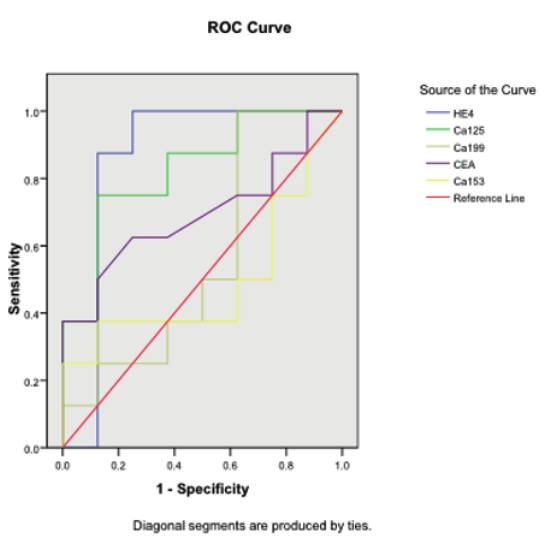
Figure 1 . ROC of examined tumor markers Table 3. Correlation coeffi cients between discriminating variables